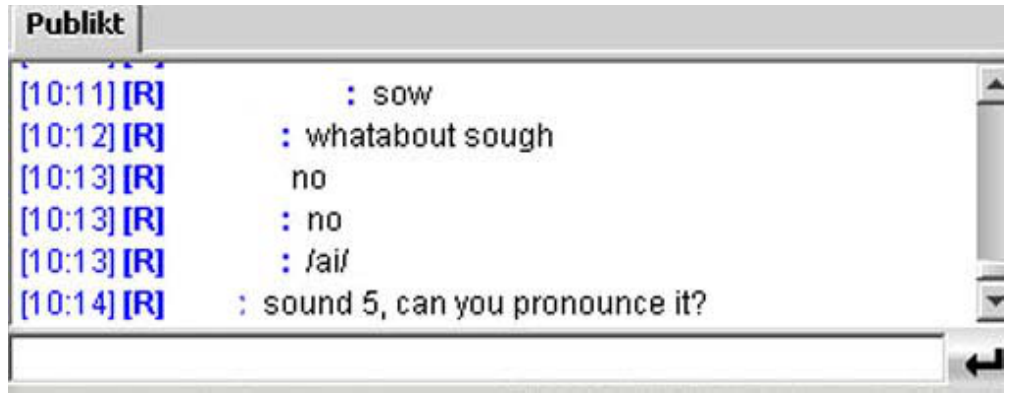
Figure 6 . Answers (names removed from image).